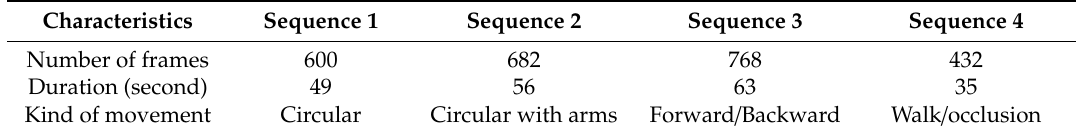
Table 1. Specification of the collected video